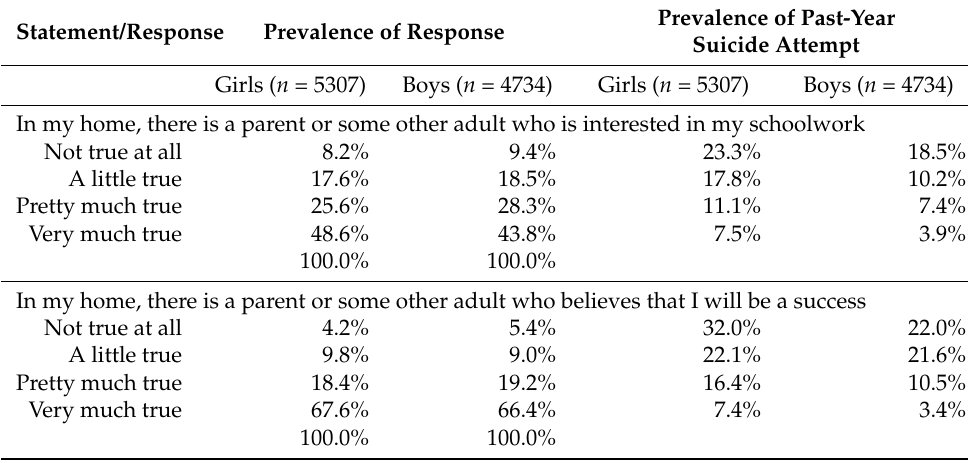
Table 1. Weighted prevalence of factors hypothesized to be protective with regard to past-year suicide attempts among Hispanic schoolchildren by sex, 2019 NM